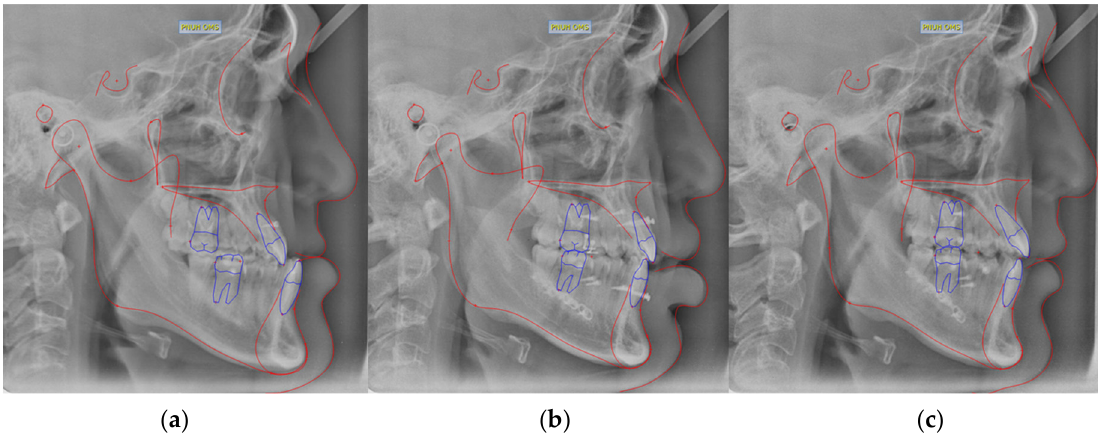
Figure 1. Orthognathic surgery patient with clear aligners. ( a ) Before surgery; ( b ) 2 days after surgery; ( c ) 6 months postoperative radiograph image. Braces attached to teeth were not observed on radiographs.